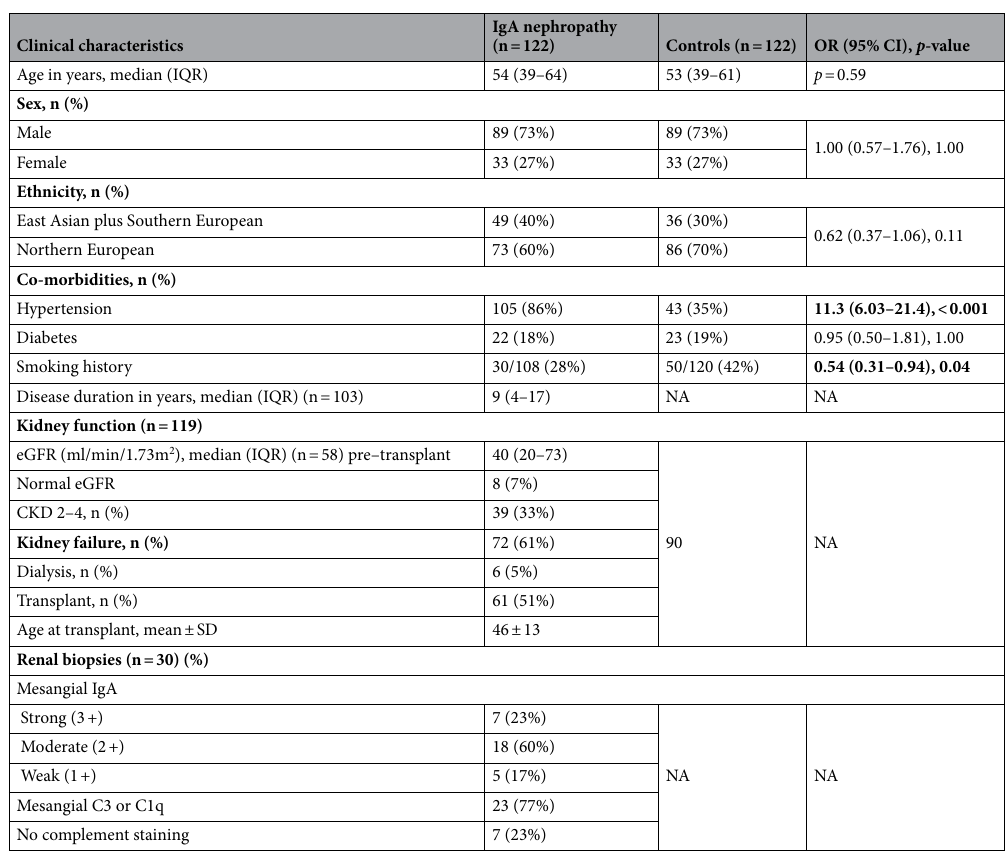
Table 1. Demographic and clinical characteristics of individuals with IgA glomerulonephritis or controls. CKD Chronic kidney disease, eGFR Estimated glomerular filtration rate mL/min/1.73m 2 , IQR Interquartile range, OR Odds ratio, CI Confidence interval, NA Not applicable. Significant values are in